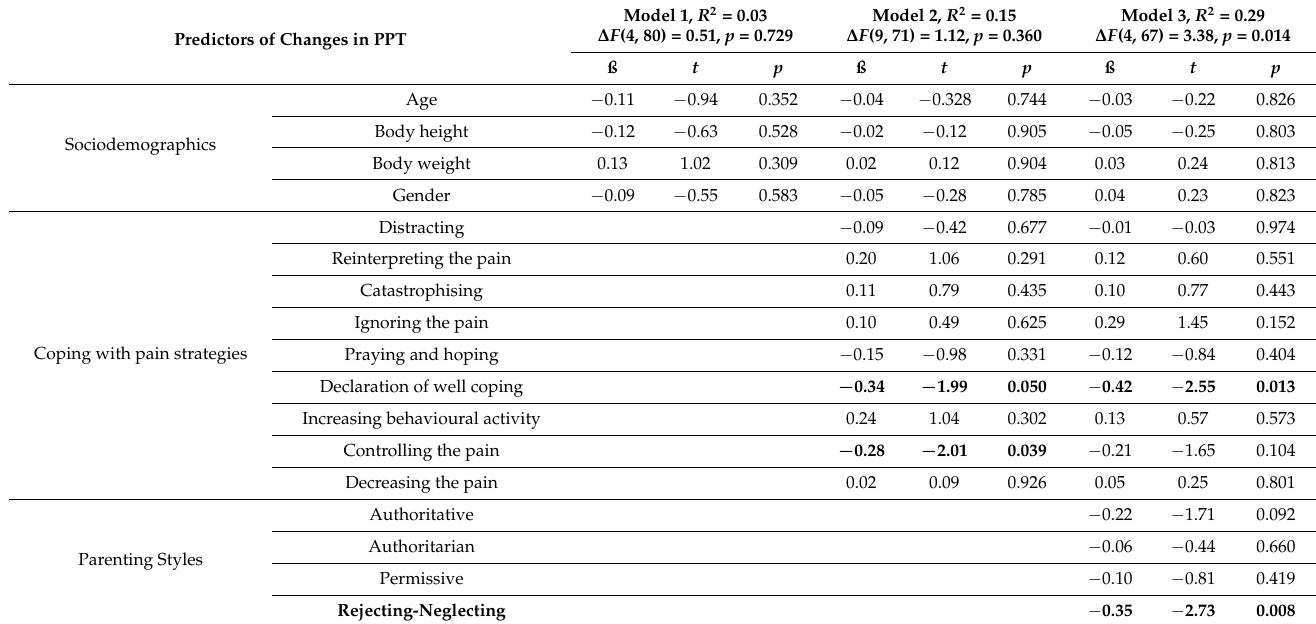
Table 3. Hierarchal linear regression predicting changes in the pressure pain threshold (PPT) after physical